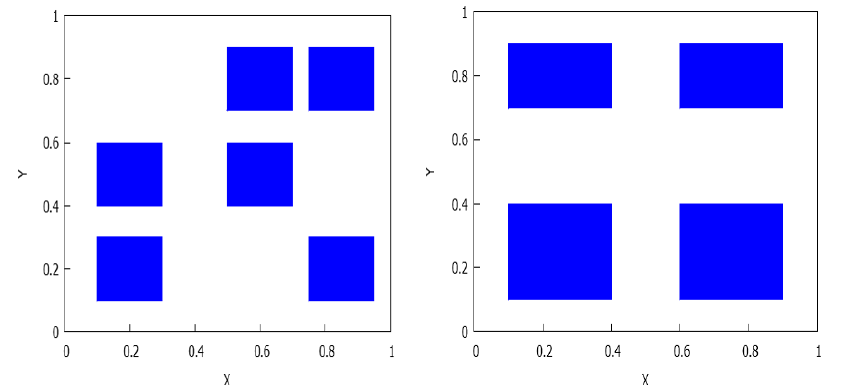
Figure 6. Mixing-mixing. Distribution D2. f 1 ( A ) ∩ Int ( B ) (cid:54) = ∅ . In the left side: p = q = 3, (cid:96) = 3 and k = 2 · (cid:96) = 6; p 1 ( π 1 ( R )) = 2 and p 2 ( π 2 ( R )) = 2 for each rectangle R in L . In the right side: p = q = 2, (cid:96) = 2, k = 2 (cid:96) = 4; again p 1 ( π 1 ( R )) = 2 and p 2 ( π 2 ( R )) = 2.